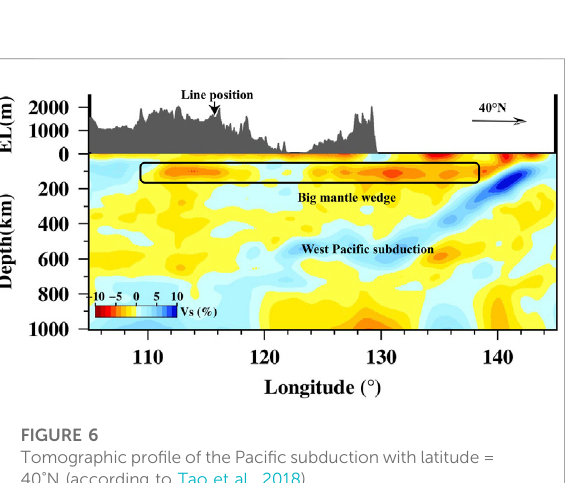
FIGURE 6 Tomographic pro fi le of the Paci fi c subduction with latitude = 40 ° N (according to Tao et al.,